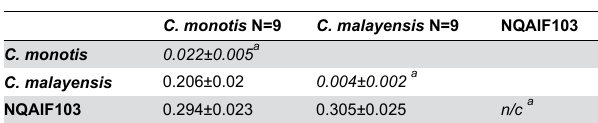
Table 4. ITS uncorrected p-distance (± S.E.) between NQAIF103 and the closely related C. monotis and C. malayensis .